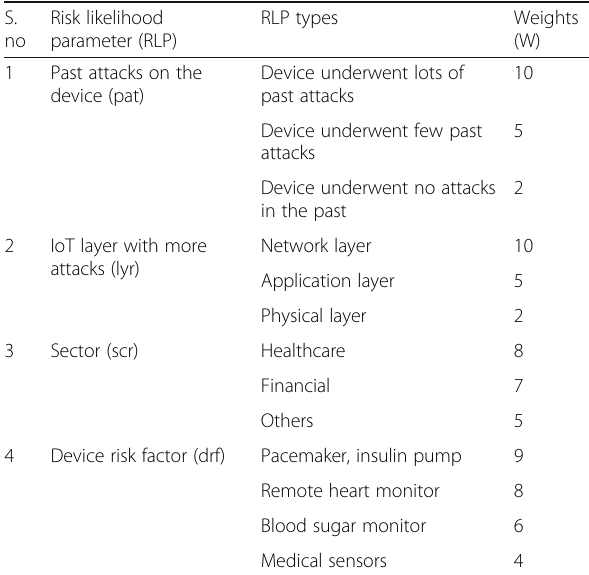
Table 7 Risk likelihood parameters with weights S. Risk likelihood no parameter (RLP)